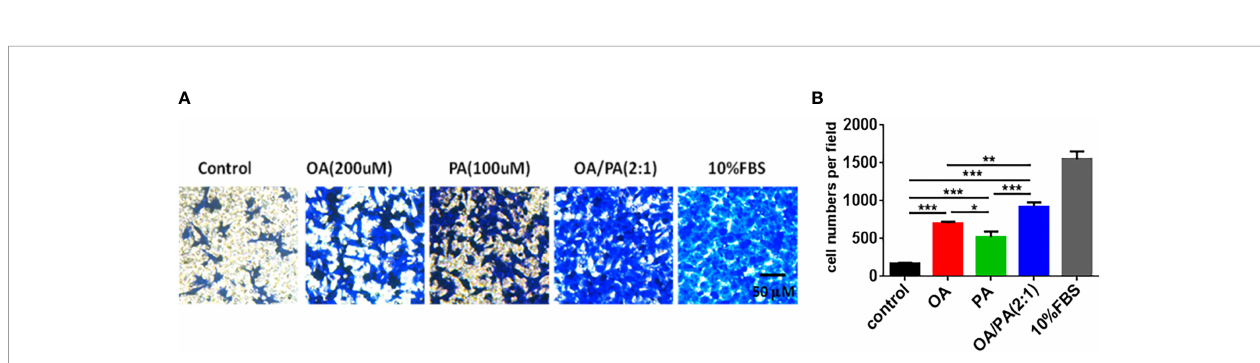
FIGURE 3 | Effects of OA and PA stimulation on ovarian carcinoma cells migration. (A) OVCAR3 cells were treated with OA and PA as described in methods, migrated cells were stained with crystal violet and photographed. Shown are representative images (100× magni fi cation). (B) The quantitative data of cells migration ability. The data are presented as means ± SEM, n = 5, *P < 0.05, **P < 0.01, ***P < 0.001.